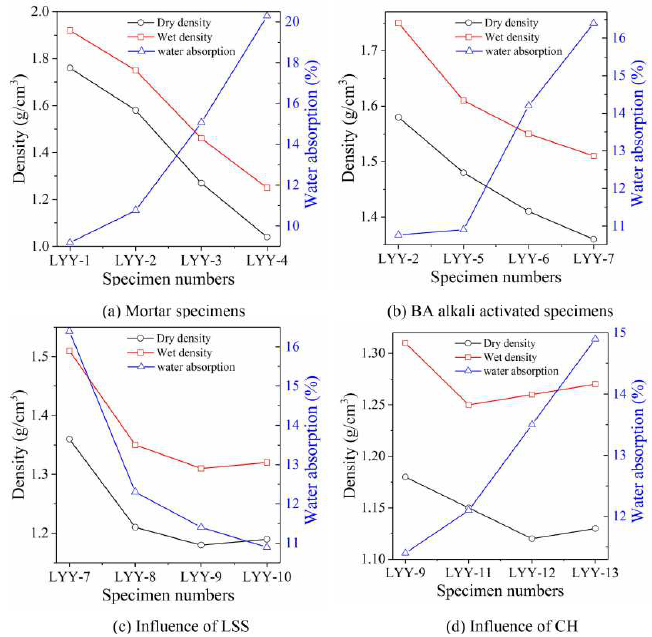
Figure 4. Analysis of dry and wet densities and water absorption.